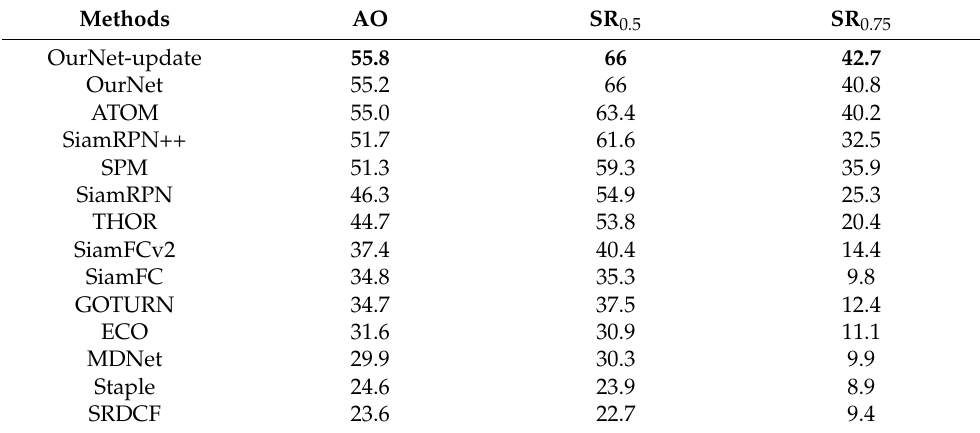
Table 2. Performance comparison on GOT-10k